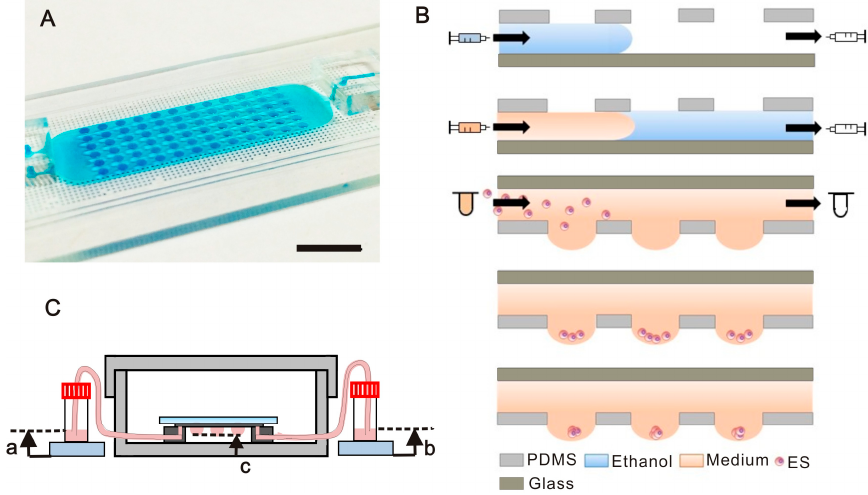
Figure 1. Illustration of the microfluidic hanging drop chip, and its setup and operation. ( A ) Photo